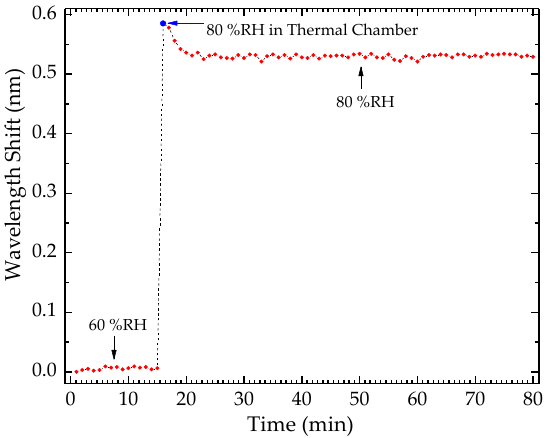
Figure 8. Response time of the sensor when subjected to a step humidity change from 60% to 80%.